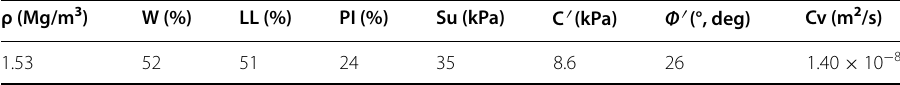
Table 1 Index properties of Leda clay in Canadian Geotechnical Research Site No.